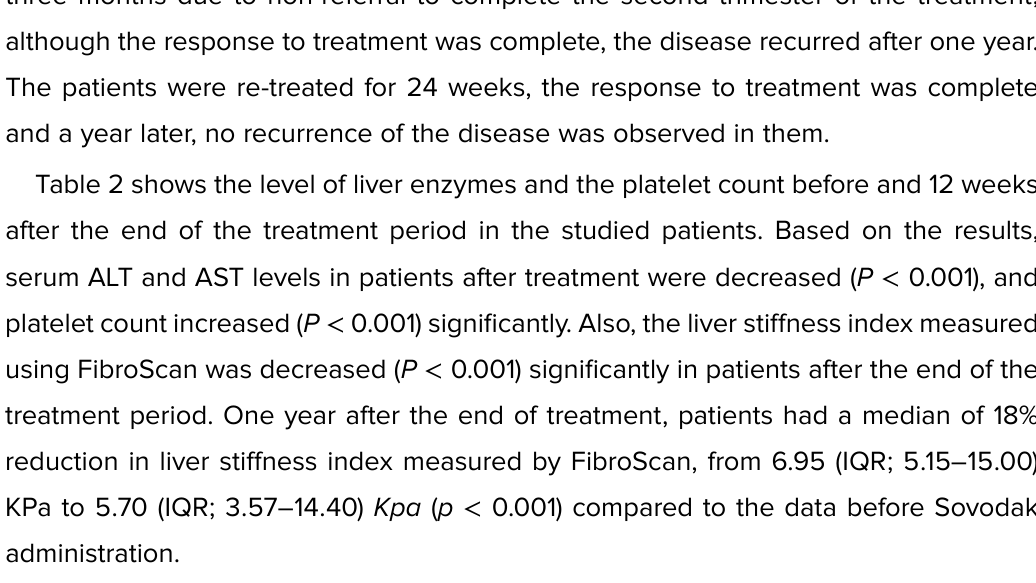
TABLE 1: Baseline characteristics of the study patients ( n =